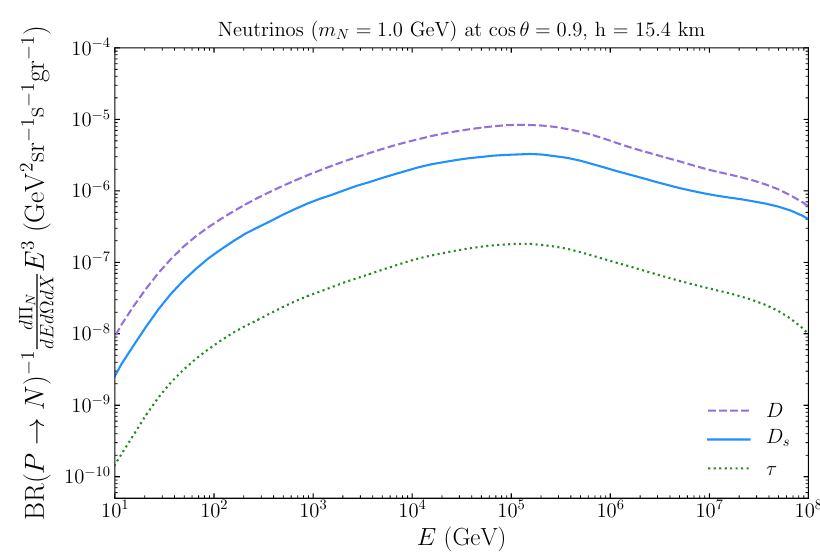
Figure 4 . Production pro(cid:12)le of HNL in the atmosphere, shown for D; D s and (cid:28) decays separately, in units of the corresponding branching ratios and for m N = 1 GeV. The pro(cid:12)le is shown at approximately 15 km from the Earth’s surface, since this is where the parent meson (cid:13)uxes are expected to be maximal, see (cid:12)gure 2, and for cos (cid:18) = 0 : 9 (we expect the signal to be largest as cos (cid:18) !